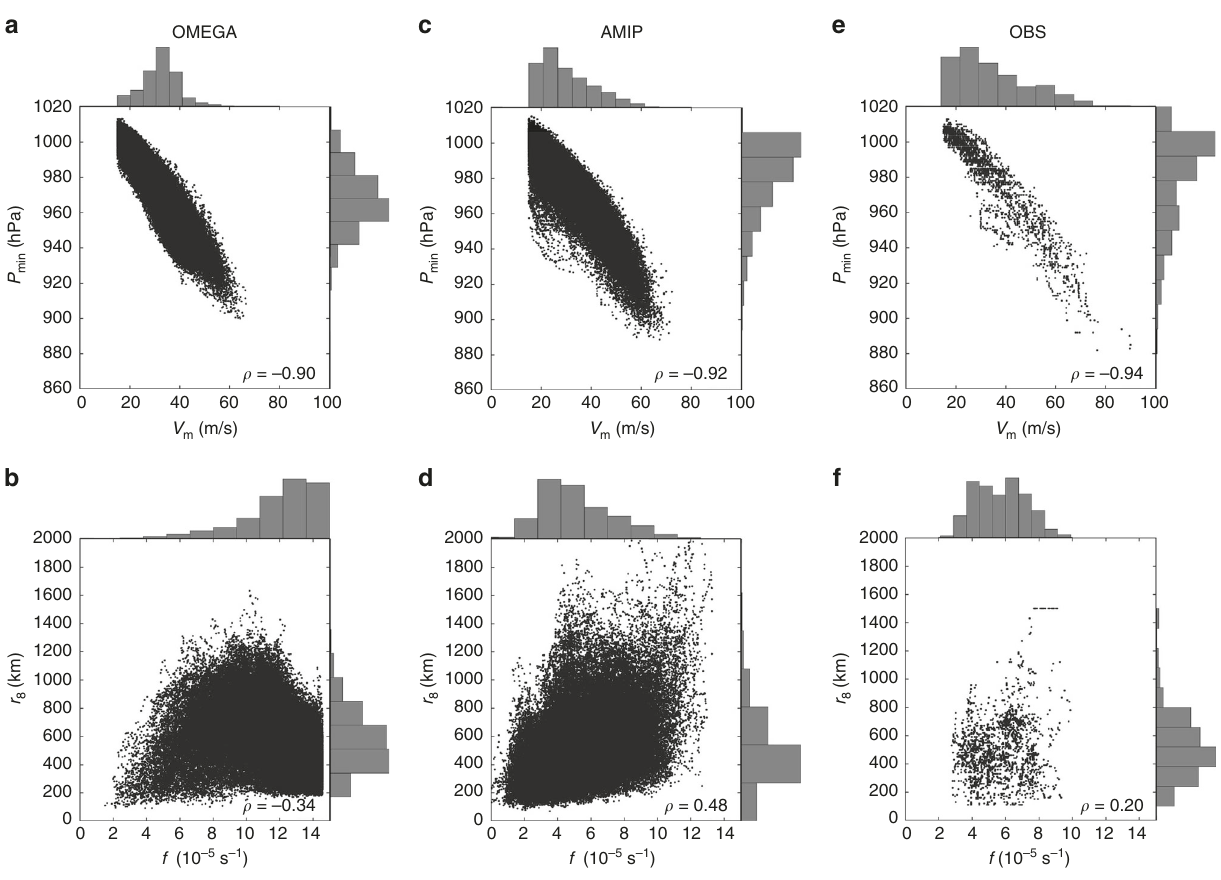
Fig. 2 Joint distributions of key storm quantities across simulations and observations. a P m and V m in OMEGA. b r 8 and f in OMEGA. c , d Same as a , b for AMIP. e , f Same as a , b for observations. Data set is fi ltered as described in the